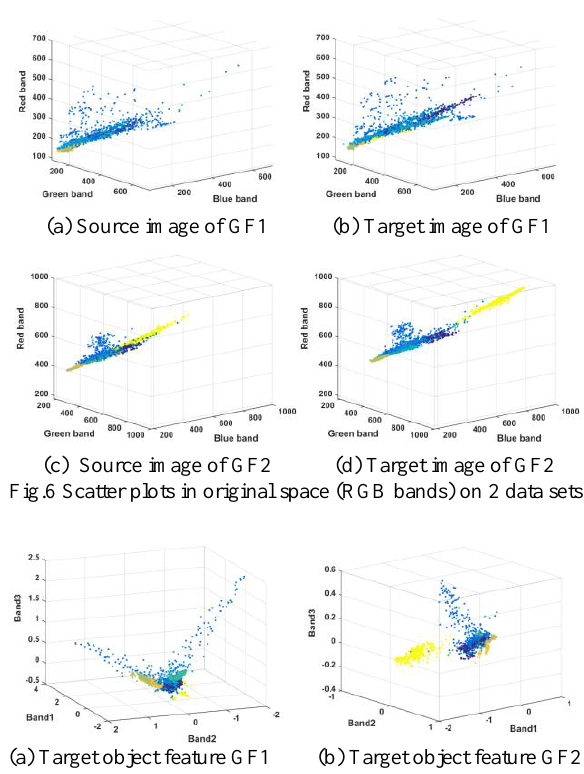
Fig.7 Scatter plots of the three first dimensions of target object feature in the alignment space on two data sets.